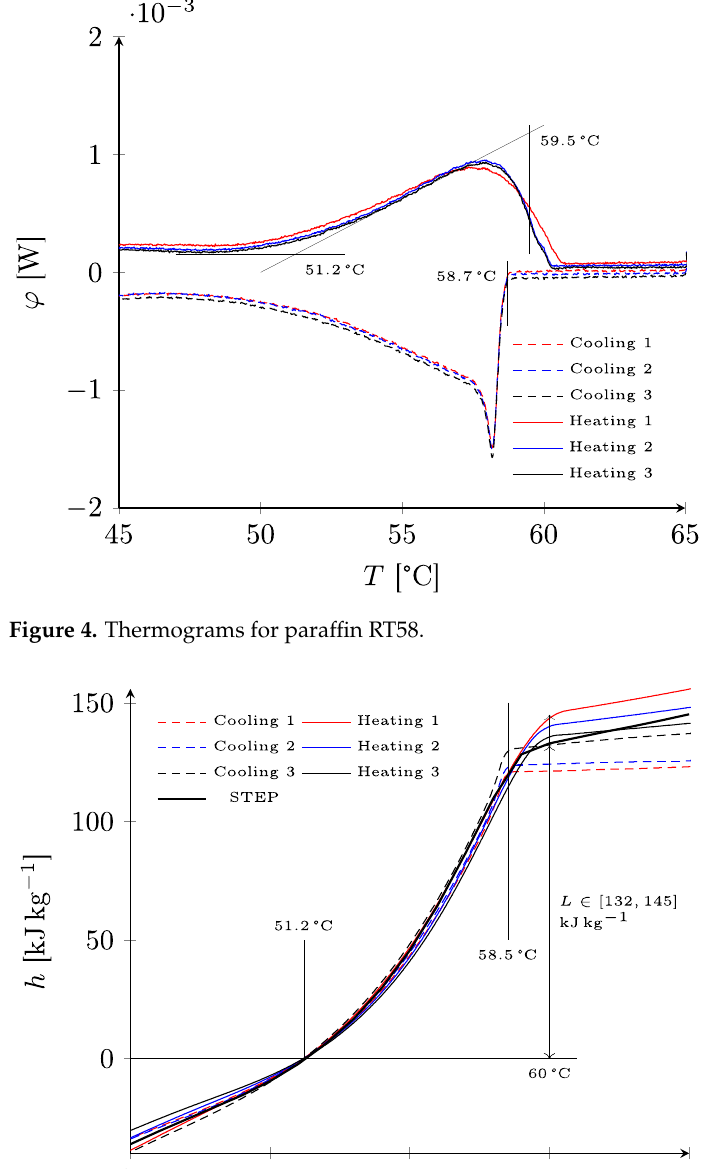
Figure 6. Thermograms for polymer PEG6000. In figure 7, the mass enthalpy was reconstructed for the three cycles by DSC, and with the STEP method. Concordant results were obtained between each cycle, except for